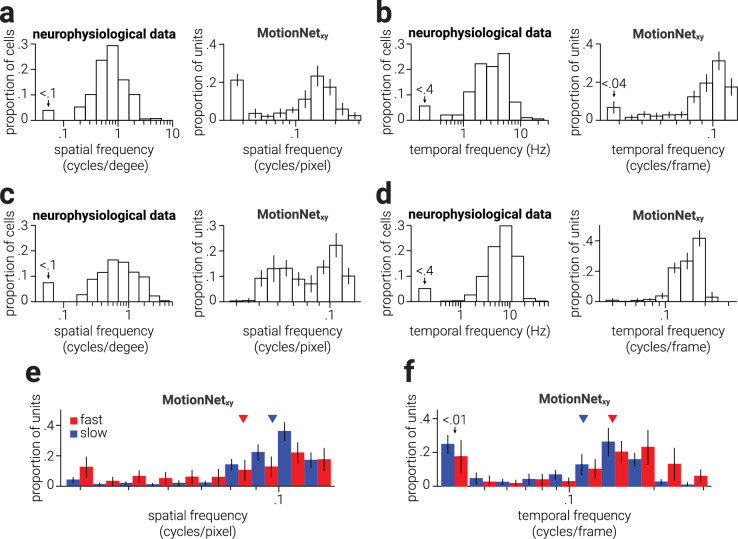
Biological and artificial visual system spatiotemporal tuning properties. (a, b, left) Replotted data from O'Keefe et al. (1998) showing the proportion of spatiotemporal cells in owl monkey V1 tuned to a range of spatial (a) and temporal frequencies (b). (a, b, right) Same as (a, b, left), but for V1 units of MotionNetxy. (c, d, left) Reanalyzed data from Wang and Movshon (2016) showing the proportion of spatiotemporal cells in macaque MT tuned to a range of spatial (c) and temporal frequencies (d). (c, d, right) Same as (c, d, left), but for MT units of MotionNetxy. (e, f) Same as (a, b, right), but split into V1 units most strongly connected to MT units tuned to slower or faster speeds. Colored
arrows in (e and f) indicate the distributions means.